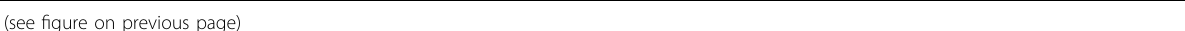
Fig. 1 Deregulation of the SIRT3/SOD2 axis in CLL cells in fl uences ROS generation. A , B CLL cells contain lower levels of O 2 − but higher levels of H 2 O 2 . Puri fi ed CLL cells or normal B-cells were stained with DHE to detect O 2 − levels ( A ) or DCFDA to detect accumulation of H 2 O 2 ( B ) and analyzed by fl ow cytometry. Results are presented as mean fl uorescent intensity (MFI) ± one standard deviation. C SOD2 remains as constitutively active. Mitochondrial fractions isolated from puri fi ed CLL cells or normal B-cells (N1 – N4) (obtained from panels A/B ) were analyzed for acetylated- SOD2 (Ac-SOD2 [K68]) in western blot using a speci fi c antibody. Total mitochondrial SOD2 was used as loading control. Densitometric analysis of the blots was also performed to determine relative levels of Ac-SOD2 (right panel). D CLL cells overexpress SIRT3. Puri fi ed normal B-cells from healthy subjects (N5 – N9) or CLL cells (P2, P3, P10 – P16) were analyzed for the expression of SIRT3 in western blot using a speci fi c antibody. Actin was used as loading control. Densitometric analysis was performed to show relative change. E ROS inhibition reduces SIRT3 level. Puri fi ed CLL cells (P57, P63, P64) treated with a ROS-inhibitor Trolox (50 µM/4 h) or left untreated were analyzed for SIRT3 expression as in panel D . GAPDH was used as loading control. Densitometric analysis was performed to show relative change (lower panel). F ROS activates SIRT3 expression. Puri fi ed CLL cells (P59, P63) treated in vitro with H 2 O 2 (50 µM and 100 µM) for 4 h were analyzed for SIRT3 expression as described in panel E . Densitometric analysis was performed to show relative fold-increase of SIRT3. G BCR activation induces SIRT3 expression. Puri fi ed CLL cells (P65, P68) treated with an anti-IgM antibody for the indicated time periods were analyzed for the expression of SIRT3 and P-BTK levels (as an indicator of BCR activation) in western blots using speci fi c antibodies. BTK and GAPDH were used as loading